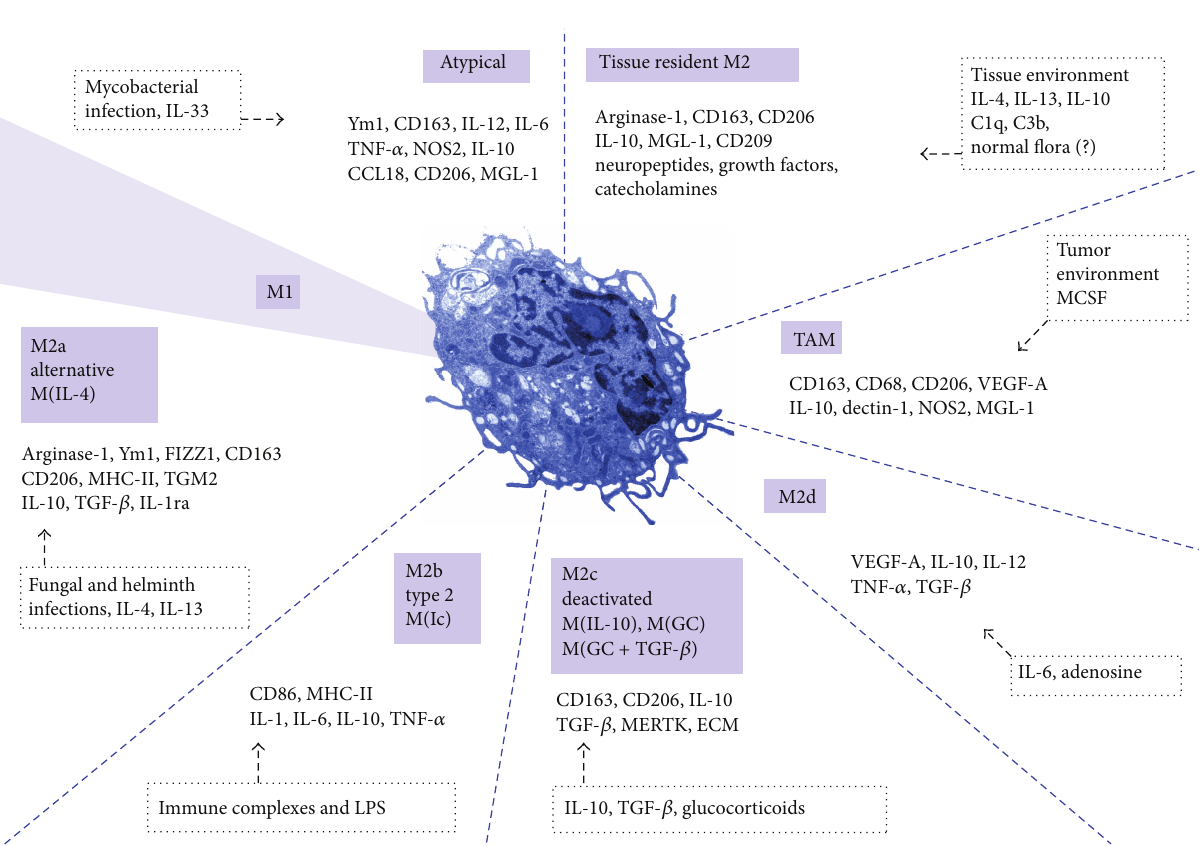
Figure 1: Overview of the macrophage activation states. Macrophage activation is widely considered as a polarization towards M1 or M2 states. However, the M2 activation state involves heterogeneous and functionally distinct macrophages. The diagram represents the most prevalent examples of the M2 activation and lists the markers associated with the distinct activation phenotypes. The upstream signals are labeled in dotted frames. Abbreviations are defined in the text.